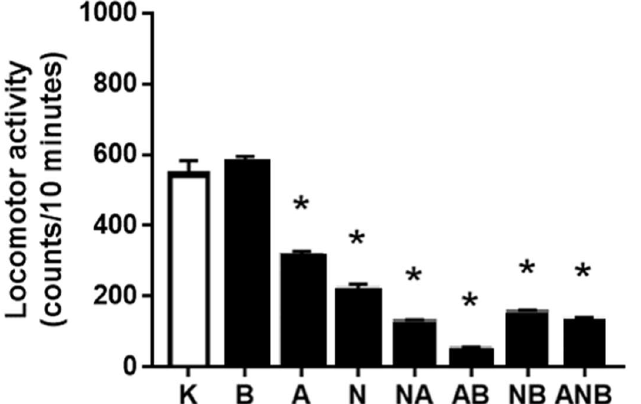
Figure 4. Locomotor activity in social interaction test. The results of locomotor activity in open field in the ketamine-induced social interaction (SIT) test, mean values, and 95 percent confidence intervals are presented. In the ketamine rats (8 mg/kg ip/3 days), medication (mg/kg ip) was at the last ketamine challenge: L-NAME (5) (N), L-arginine (100) (A), BPC 157 (0.01) (B), alone and/or together (L-NAME+L-arginine (NA), L-arginine+BPC 157 (AB), L-NAME+BPC 157 (NB), L-arginine+L-NAME+BPC 157 (ANB)), and saline 5 mL/kg ip (control ketamine) (K). The application was immediately before ketamine (L-NAME, L-arginine, and combination) or the application was immediately after ketamine (BPC 157 and combinations). Dunnett’s multiple comparison test was used to compare control group (K) with treated groups.* p < 0.05 relative to ketamine.